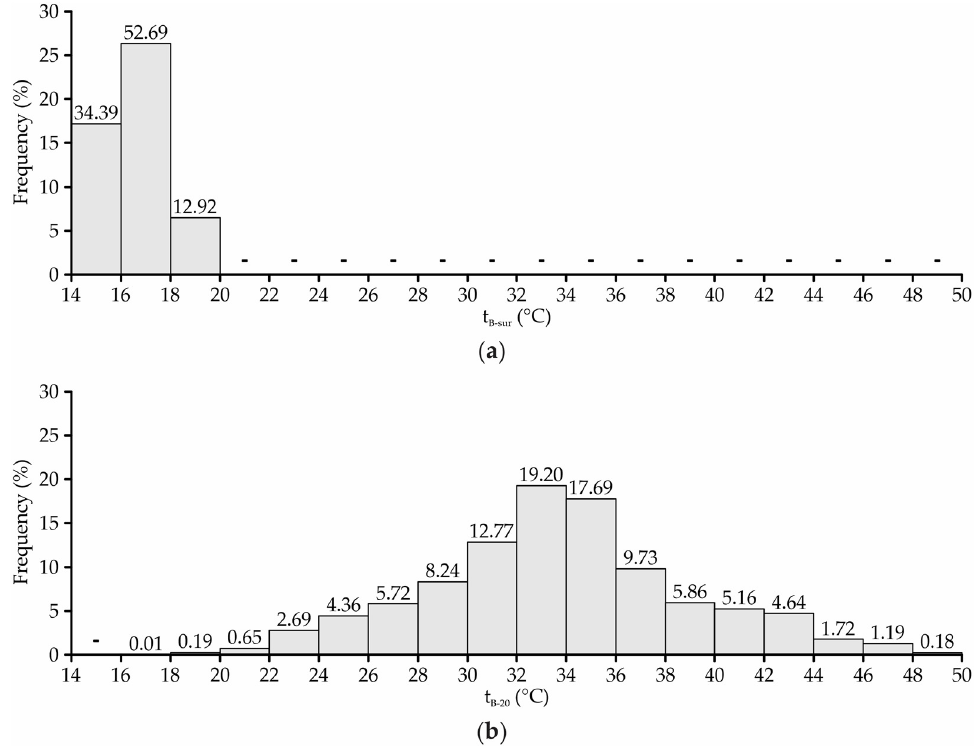
Figure 4. Frequency distribution of bedding temperature at the surface—t B-sur ( a ) and at a depth of 0.2 m—t B-20 ( b ). 0.2 m—t B-20 ( b